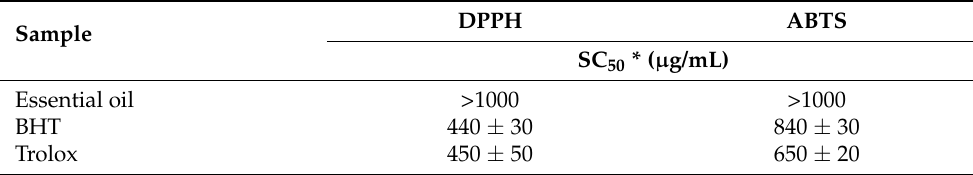
Table 4. Antioxidant activity of essential oils of Piper carpunya.